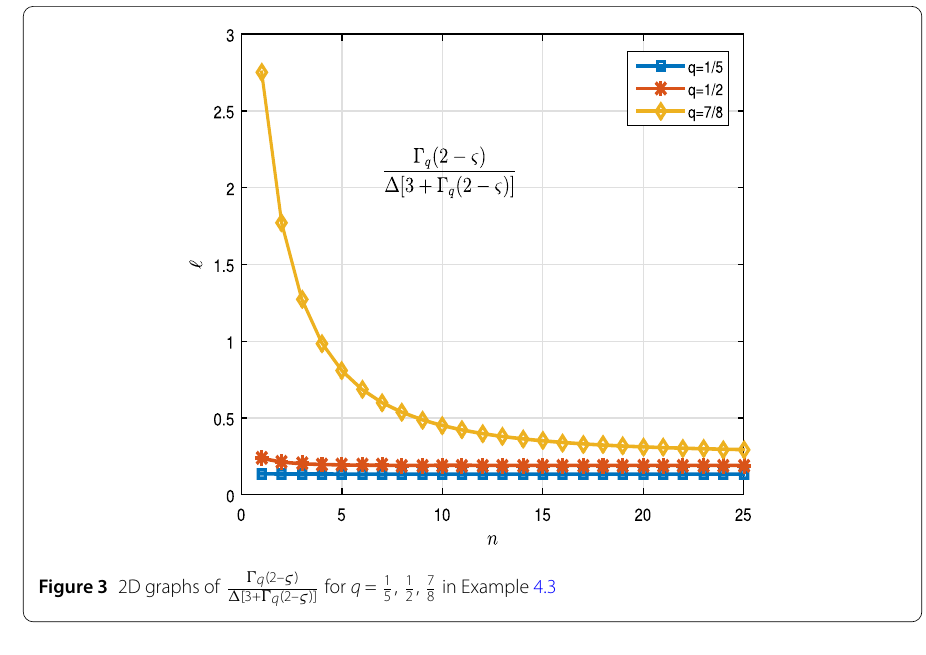
Figure 3 2D graphs of